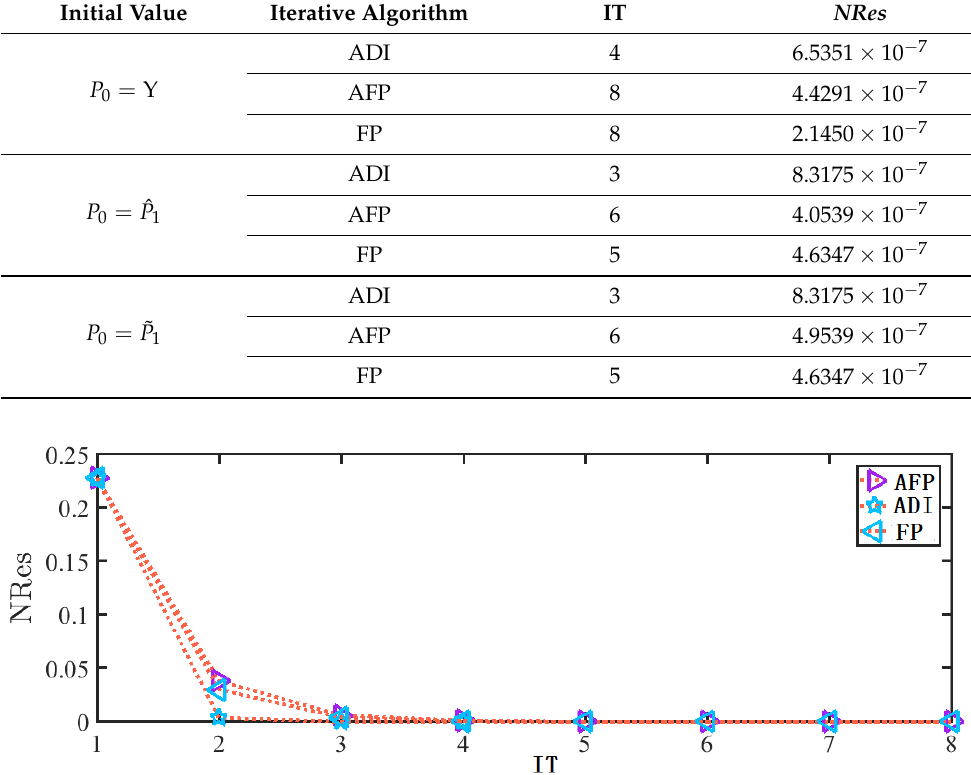
Figure 4. The relation of IT and NRes for the three algorithms when P 0 = Υ